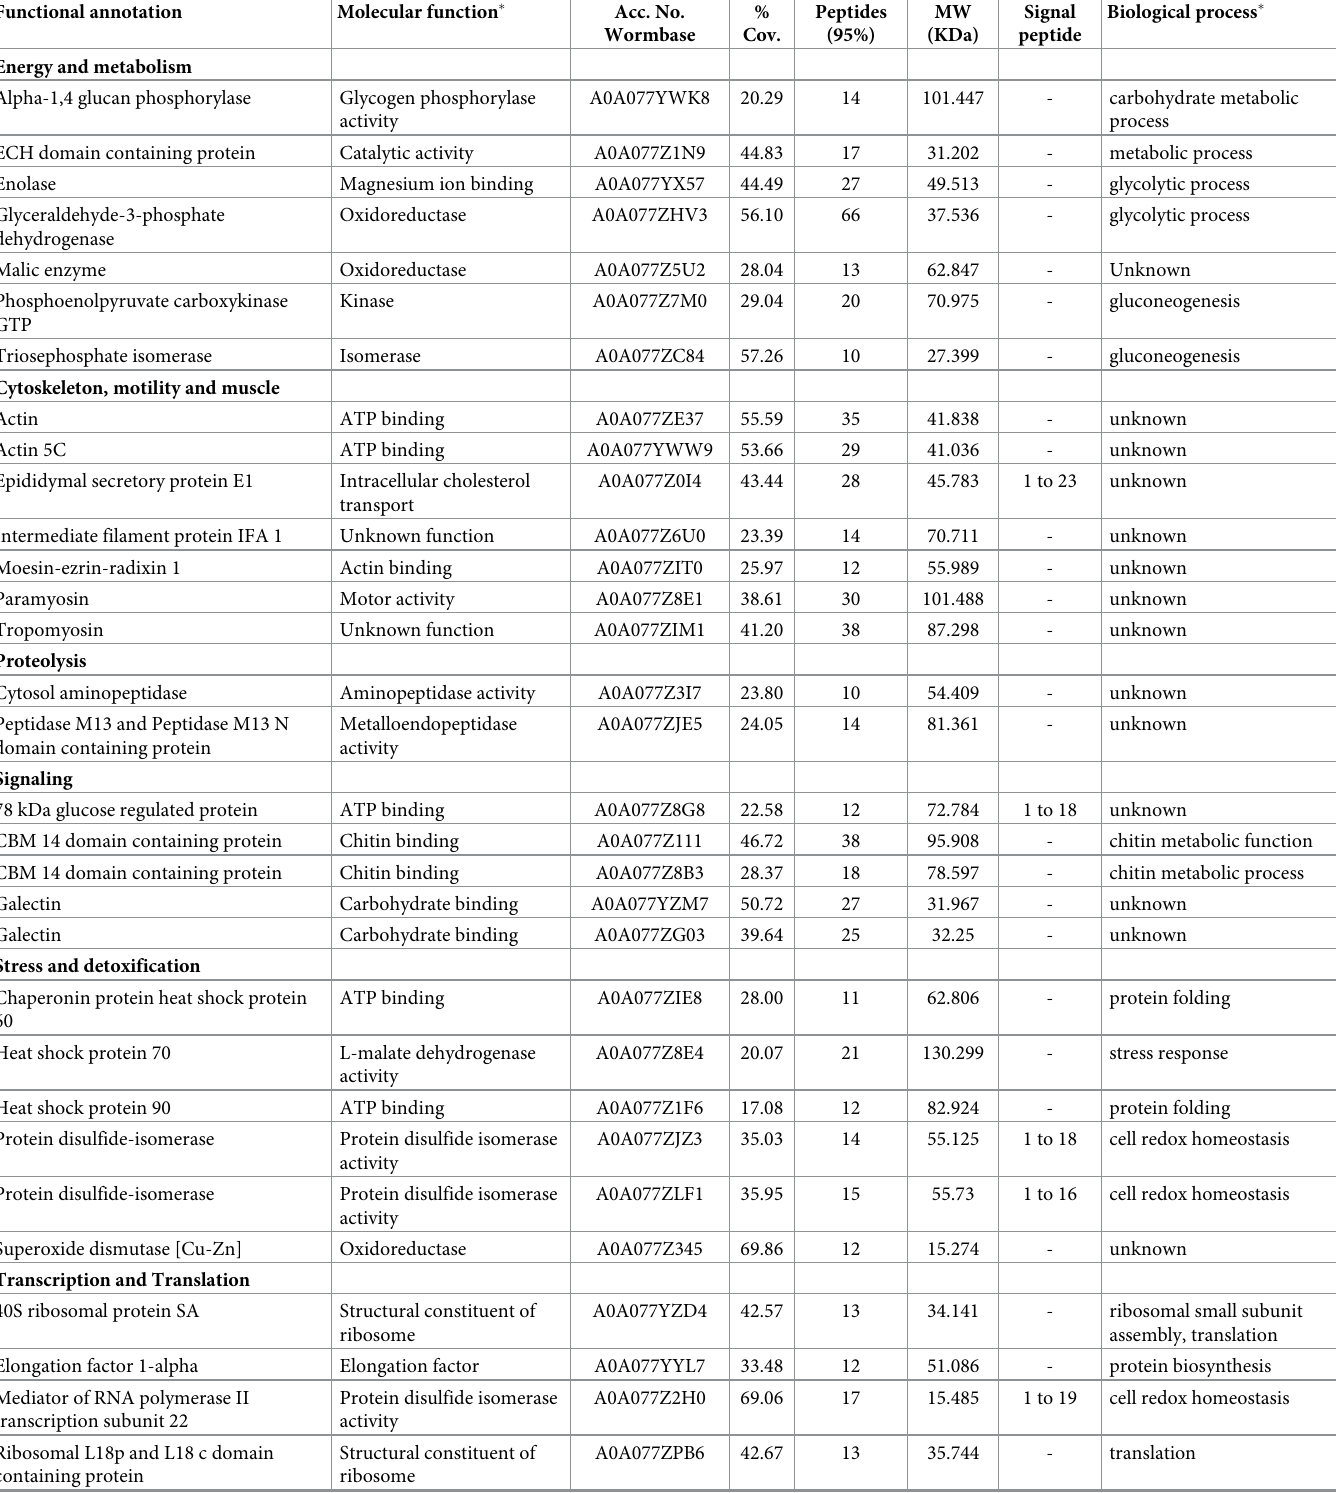
Table 1. Main proteins identified in the EE (10 or more distinct peptides) organized by functional annotation. Only a single annotation was assigned to a given